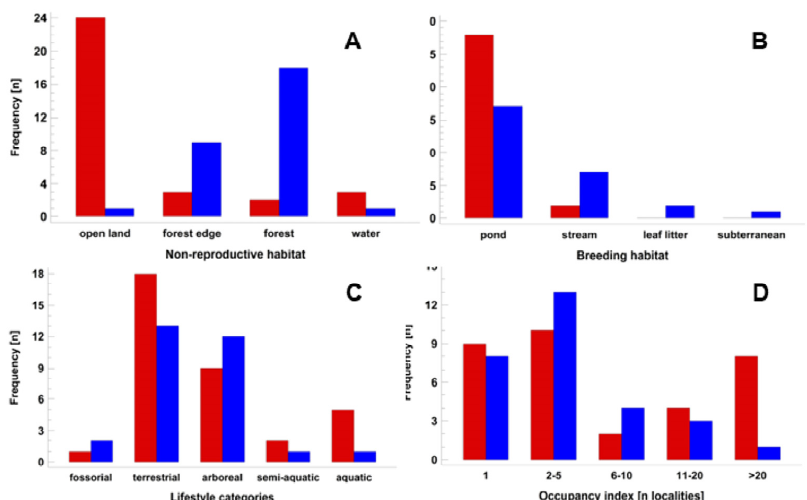
Figure 20. Frequency histograms of life-history features in lowland (red) and highland metacom- munities (blue). ( A , B ) Habitat preferences of non-reproductive and breeding adults; ( C ) Lifestyle categories; ( D ) occupancy index as a proxy of country wide distribution range. Note that the shared species of low- and highland metacommunities are included in each and that some species show more than one